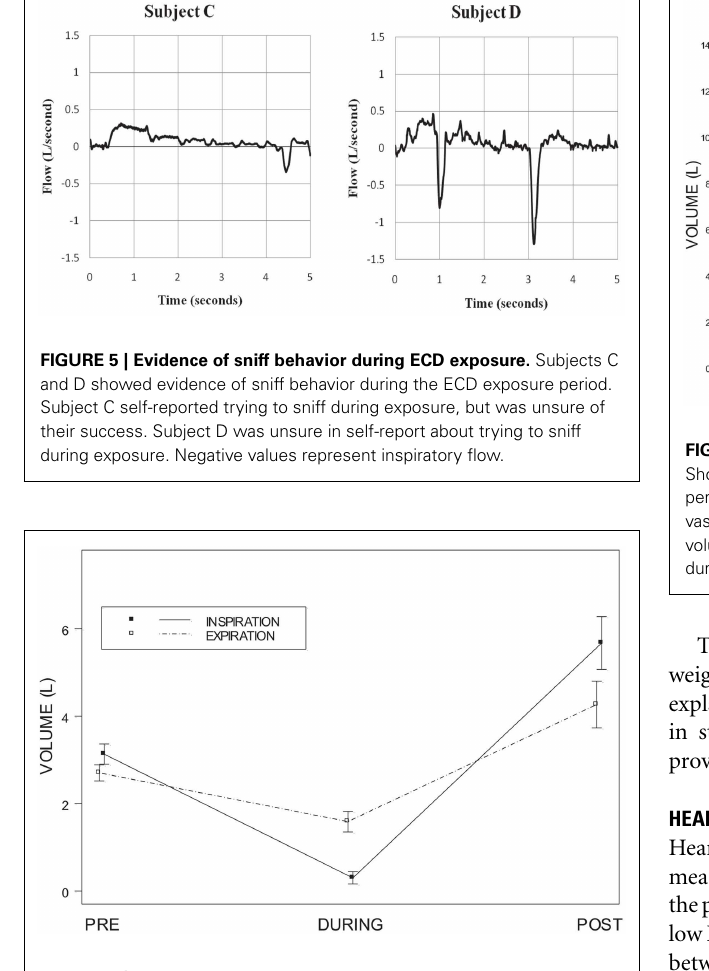
FIGURE 6 | Inspiratory and expiratory volume. Shows inspiratory and expiratory volumes for each of the 5-s periods of time measured: pre-ECD, during ECD, and post-ECD. Both inspiration and expiration significantly decreased during ECD exposure.